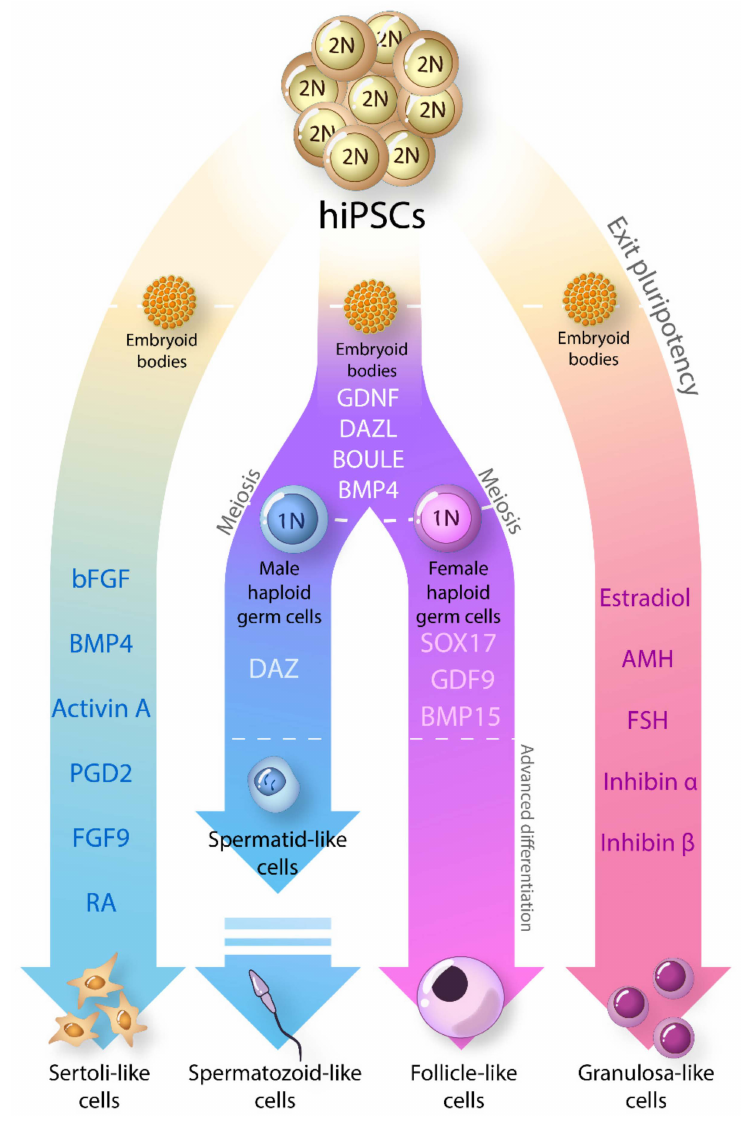
Figure 3. Known factors involved in guided differentiation of hiPSCs into gonadal cells: Expression of growth factors can guide the differentiation of embryoids bodies into Sertoli, Granulosa or germ cell-like cells. Bone morphogenic protein4 (BMP4), ActivinA, prostaglandin2 (PDG2)and fibroblast growthfactor 9(FGF9) and retinoid acid (RA) successfully differentiated into Sertoli-like cells are able to endogenously express SOX9, anti-Mullerian hormone (AMH), claudin-11 (CLDN11) and other Sertoli markers [37,98]. Granulosa-like cell differentiation has shown to be stimulated by estradiol, AMH, follicle stimulating hormone (FSH), inhibin α and inhibin β [109–111]. BMPs proteins together with GDNF, DAZL and BOULE are known to initiate differentiation into a meiotic primordial germ cell-like (PGCL) phenotype [55,102–104]. While complete spermatogenesis in human cells was not achieved yet, PGCs differentiated with SOX17, GDF9 and BMP15 factors showed the ability to induce folliculogenesis